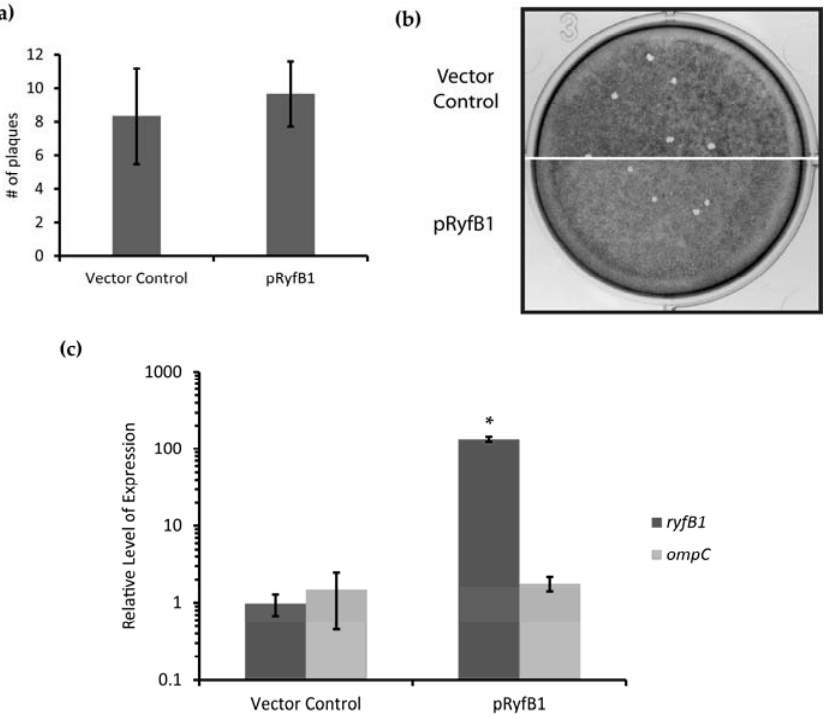
Figure 10. Overproduction of RyfB1 does not impact plaque formation of S. dysenteriae . ( a ) Overproduction of RyfB1 by S. dysenteriae did not alter the number of plaques as compared to a vector control. ( b ) A monolayer of Henle cells was infected with S. dysenteriae containing a vector control or overproducing RyfB1 (pRyfB1). Overproduction of RyfB1 did not alter the plaque phenotype as from the vector control. ( c ) qRT-PCR was used to measure expression of RyfB1 and ompC . Significant overproduction of RyfB1 did not impact the relative levels of ompC transcript. * denotes a significant difference where p < 0.001. The relative levels of RyfB1 and ompC were calculated using the ∆∆